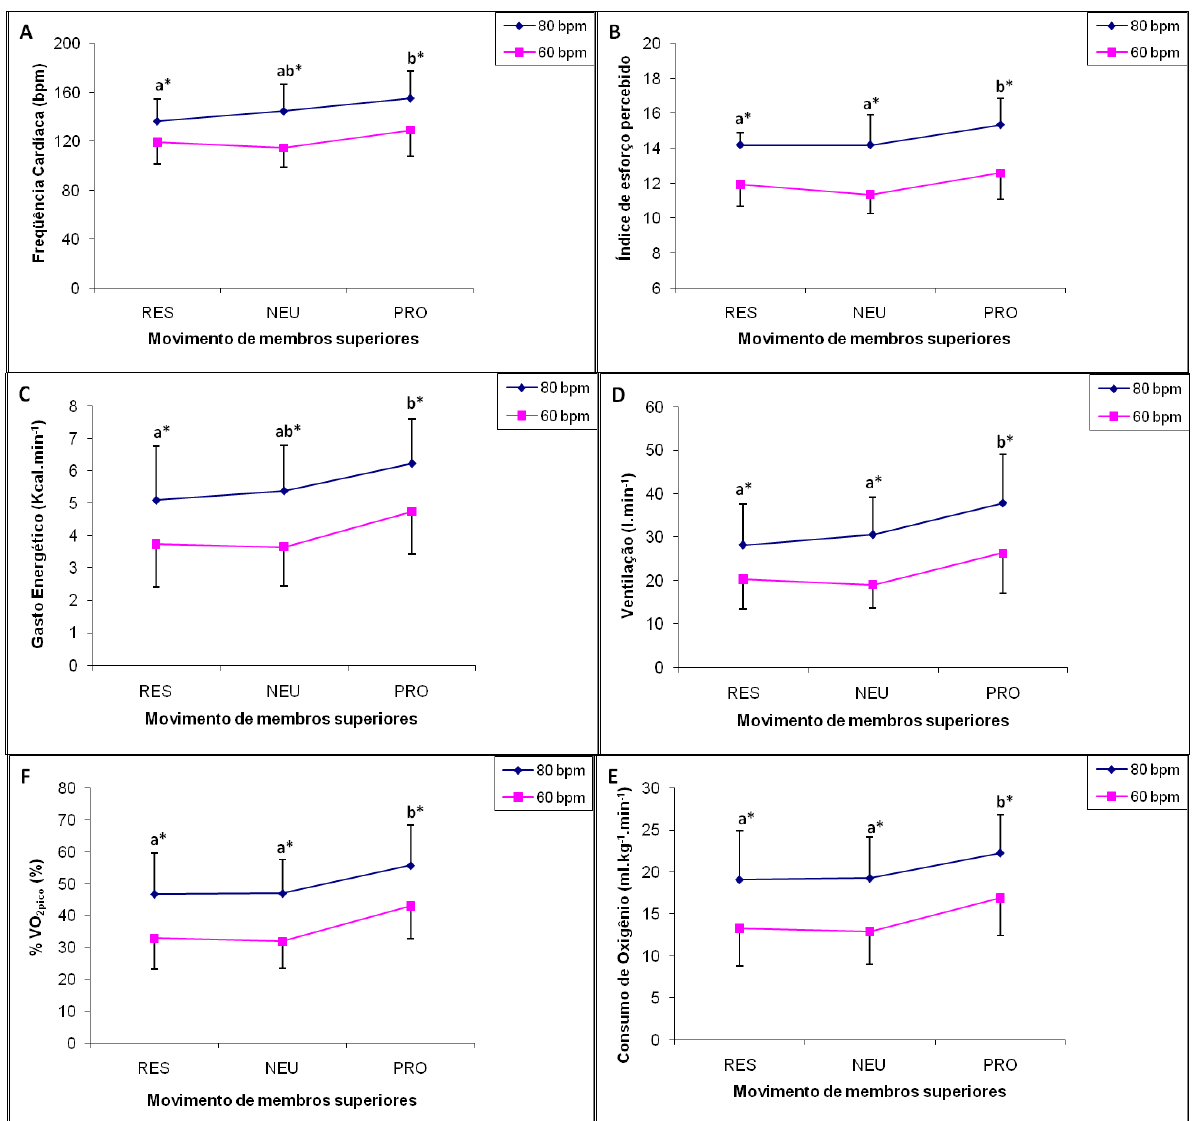
Figura 2. Comportamento das variáveis Freqüência Cardíaca (FC), Gasto energético (GE), Consumo de Oxigênio Relativo (VO ), % do Consumo de Oxigênio de Pico (%VO 2 e Ventilação (VE) durante a execução da corrida em piscina funda nas diferentes cadências e Movimentos de Membros